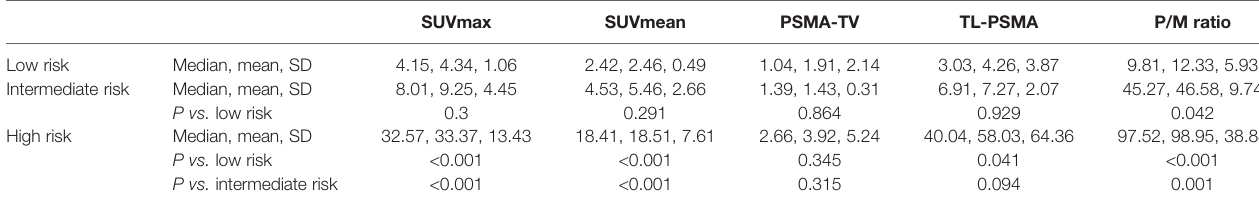
TABLE 2 | 18 F-labeled PSMA PET/CT parameters in newly diagnosed prostate cancer patients of different risks.